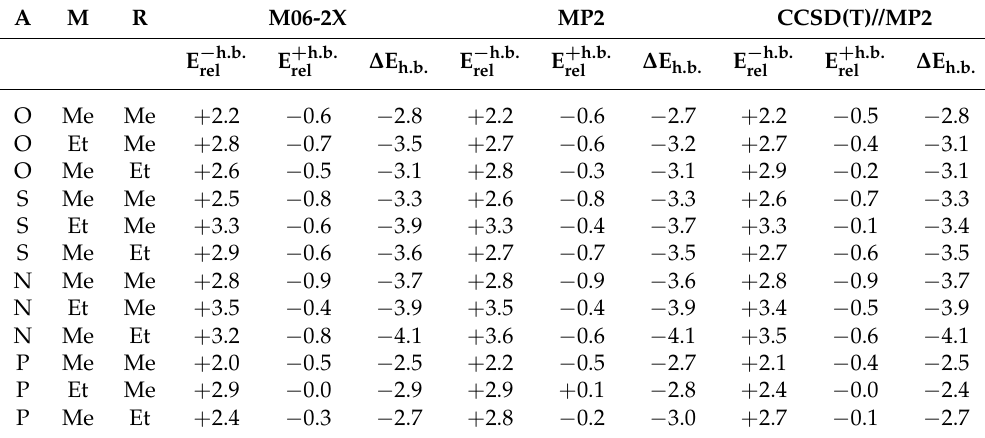
Table 1. Relative electronic energies (E − h.b. basis